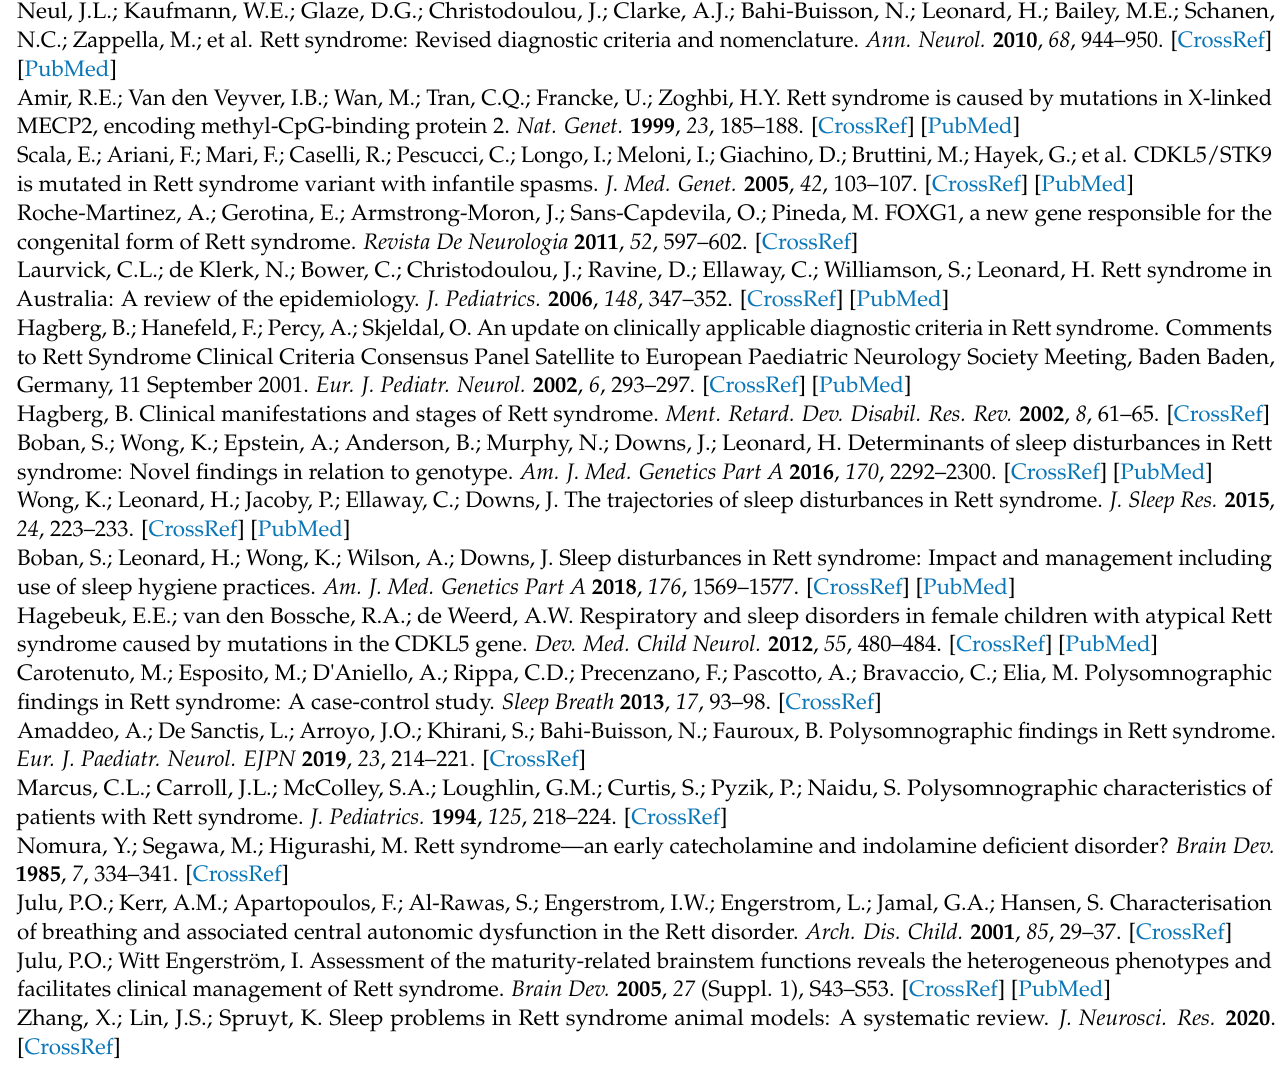
Table S1: Search items with a cut-off date of 6th February 2022. Table S2: Summarized sleep respiratory event